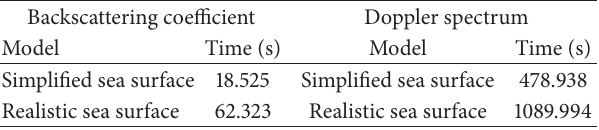
obtained by averaging 50 surface realizations. The surfaces Table 1: Comparison of simulating time by two